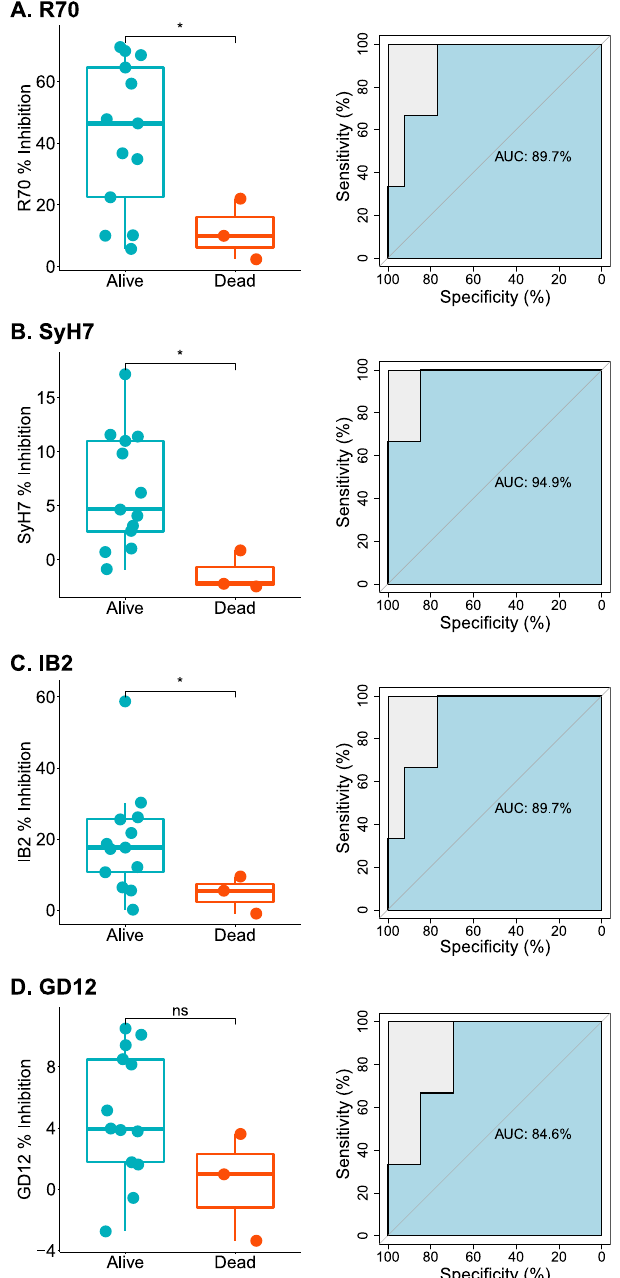
Fig. 5 Correlations between serum IgG EPICC inhibition values and immunity to RT challenge. Serum samples from control (group A) and RiVax ® -vaccinated Rhesus macaques (groups B – D) were collected on study day 110, as described in Table 1. Sample were examined for inhibitory activity in the EPICC assay using mAbs A R70/PB10, B SyH7, C , IB2, and D GD12, as described in the “ Methods ” . Left panels: Comparisons of EPICC inhibition values (%) between survivors and decedents are shown in boxplots on the left with asterisks denoting signi fi cant differences, as determined by Mann – Whitney U tests. The thick horizontal line in each box represents the median. The box de fi nes the 1 and 3 quartiles, and the whiskers are max/min values. Right panels: ROC curve analysis was performed to assess the predictive ability of each analyte, with speci fi city plotted against sensitivity. AUC values are shown for each curve in the center of the plots, with an AUC of 100% representing a perfect predictive